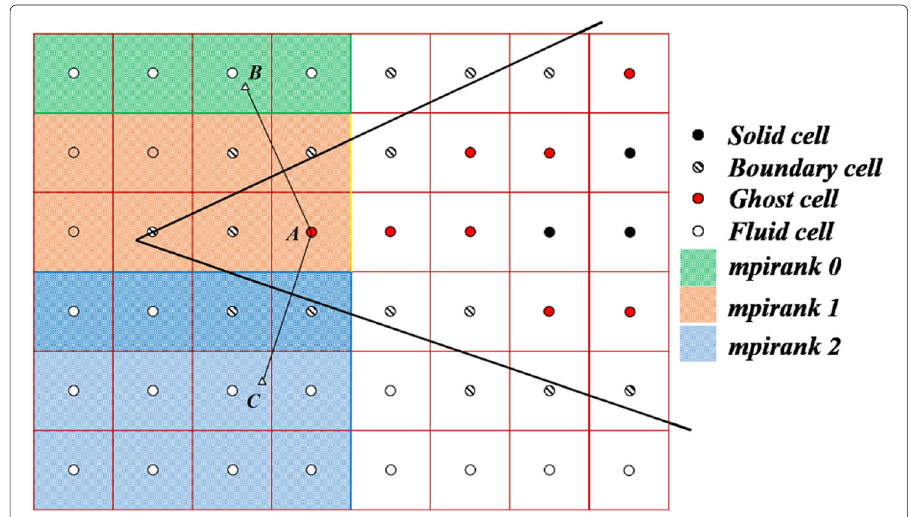
Fig. 7 Multi-valued ghost-cell near a sharp leading edge (different color areas indicate a possible partition